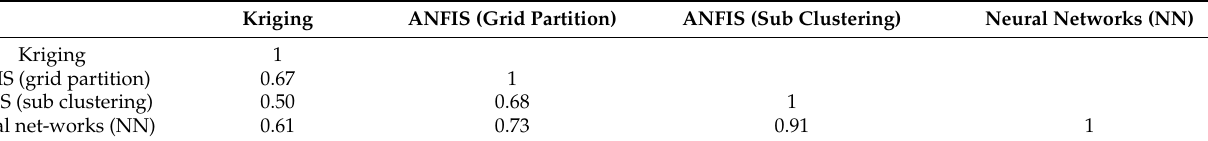
Table 2. R squared of Cu % values of blocks estimated by different methods (kriging, ANFIS, and NN).